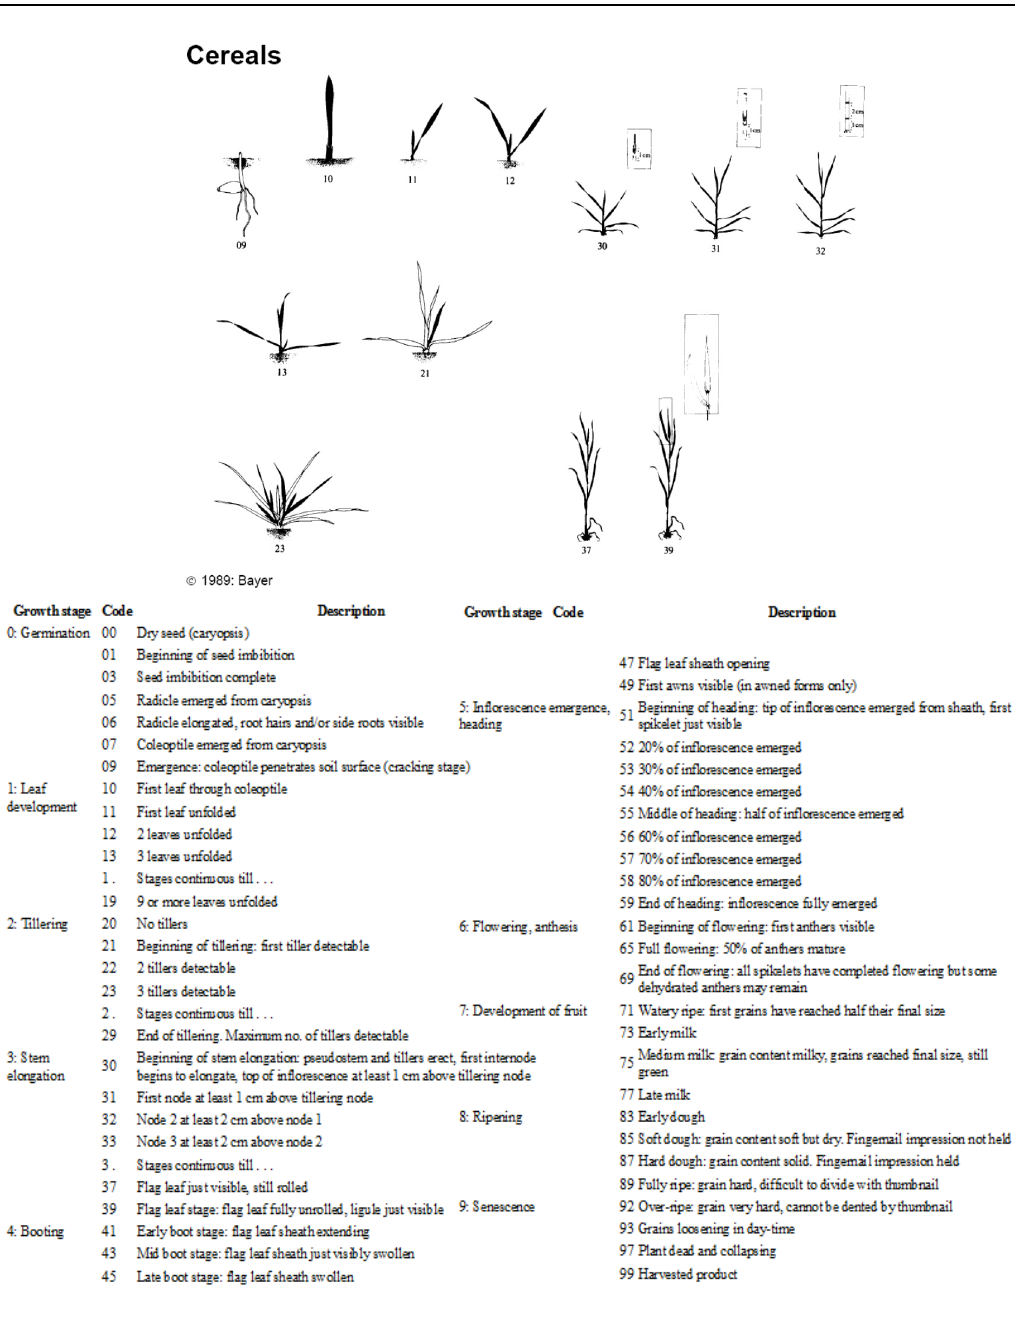
Figure 2. BBCH extract for cereals growth stages. Source: [10].